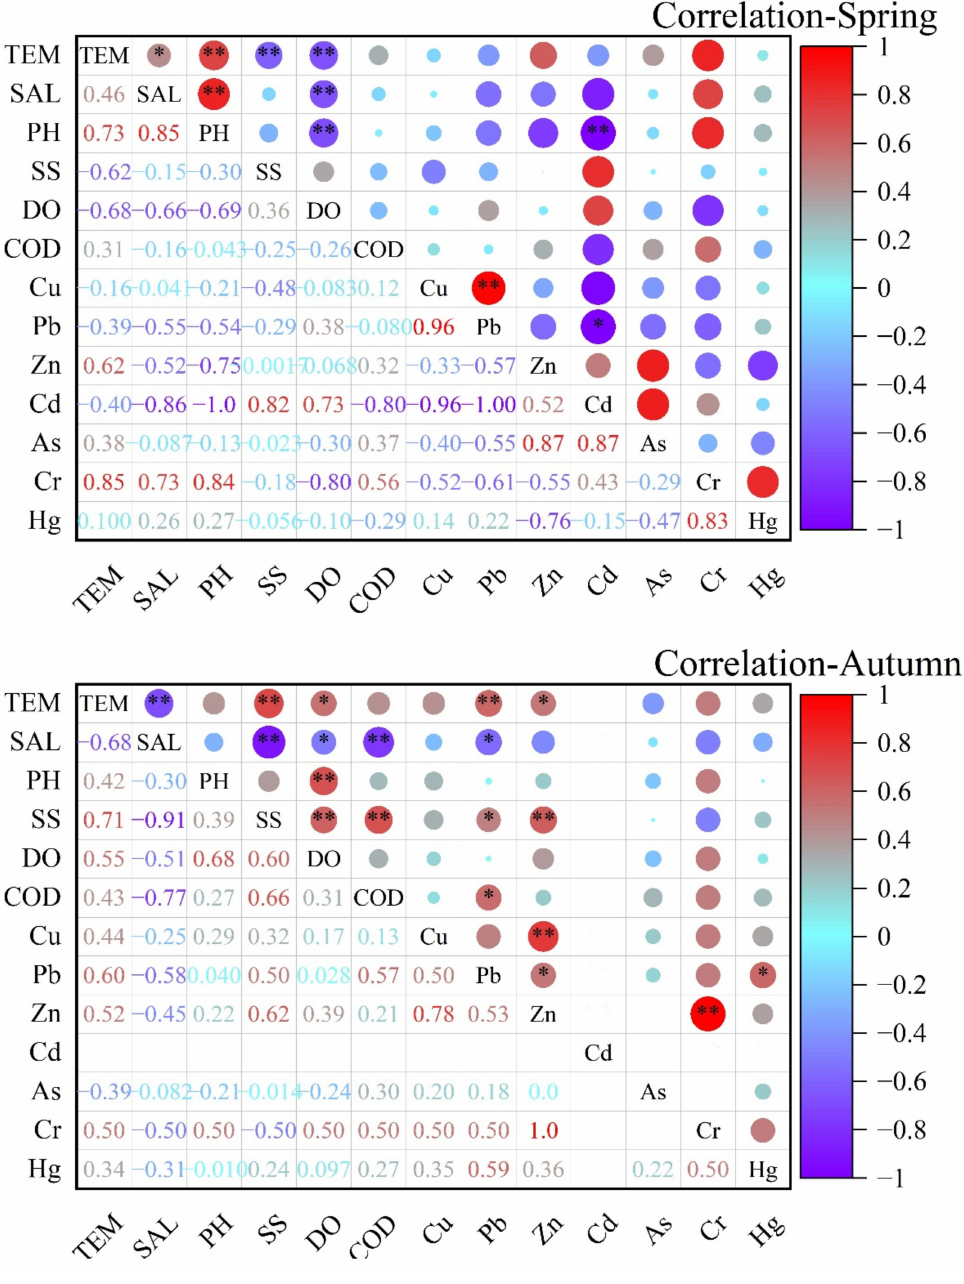
Figure 5. The correlation analysis of heavy metals in the seawater of coastal Shantou (* p < 0.05; ** p <